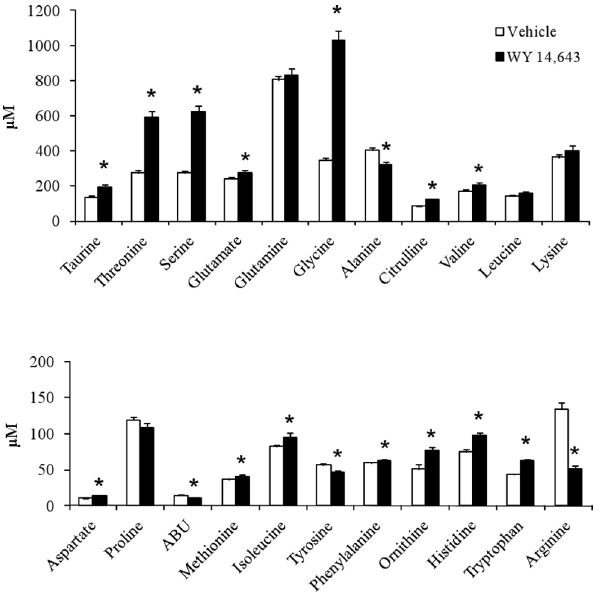
Fig. 2. Plasma amino acid concentrations. Plasma samples were collected after 4 weeks of treatment with WY 14,643 (n 5 15) or vehicle (n 5 15) in 9 hour fasted rats. ABU, 2-aminobutyric acid. Values are given as means ¡ SEM. * P ,